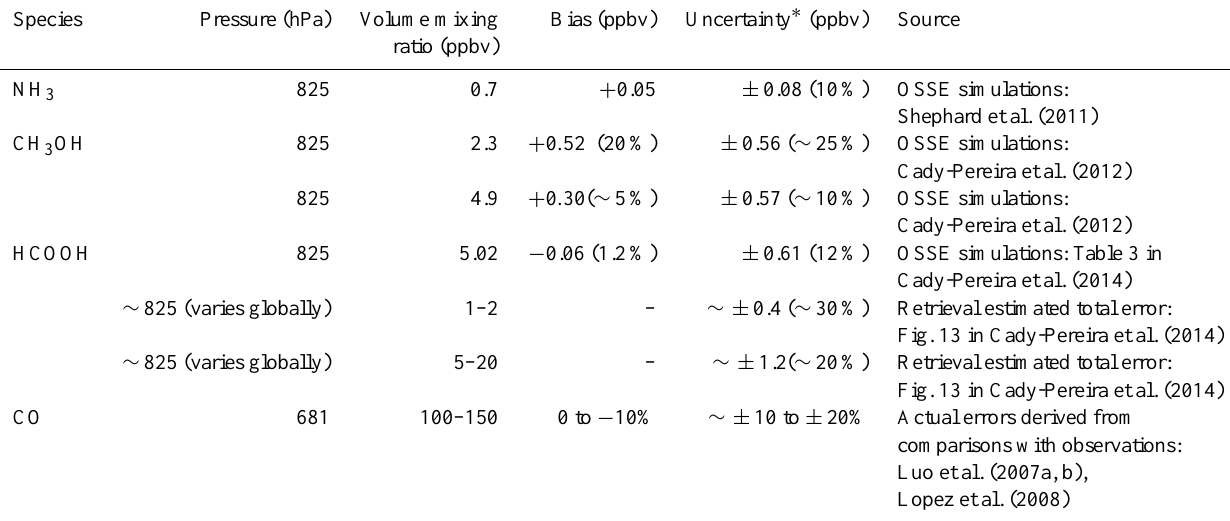
Table 1. Summary of reported estimates of TES retrieval errors.